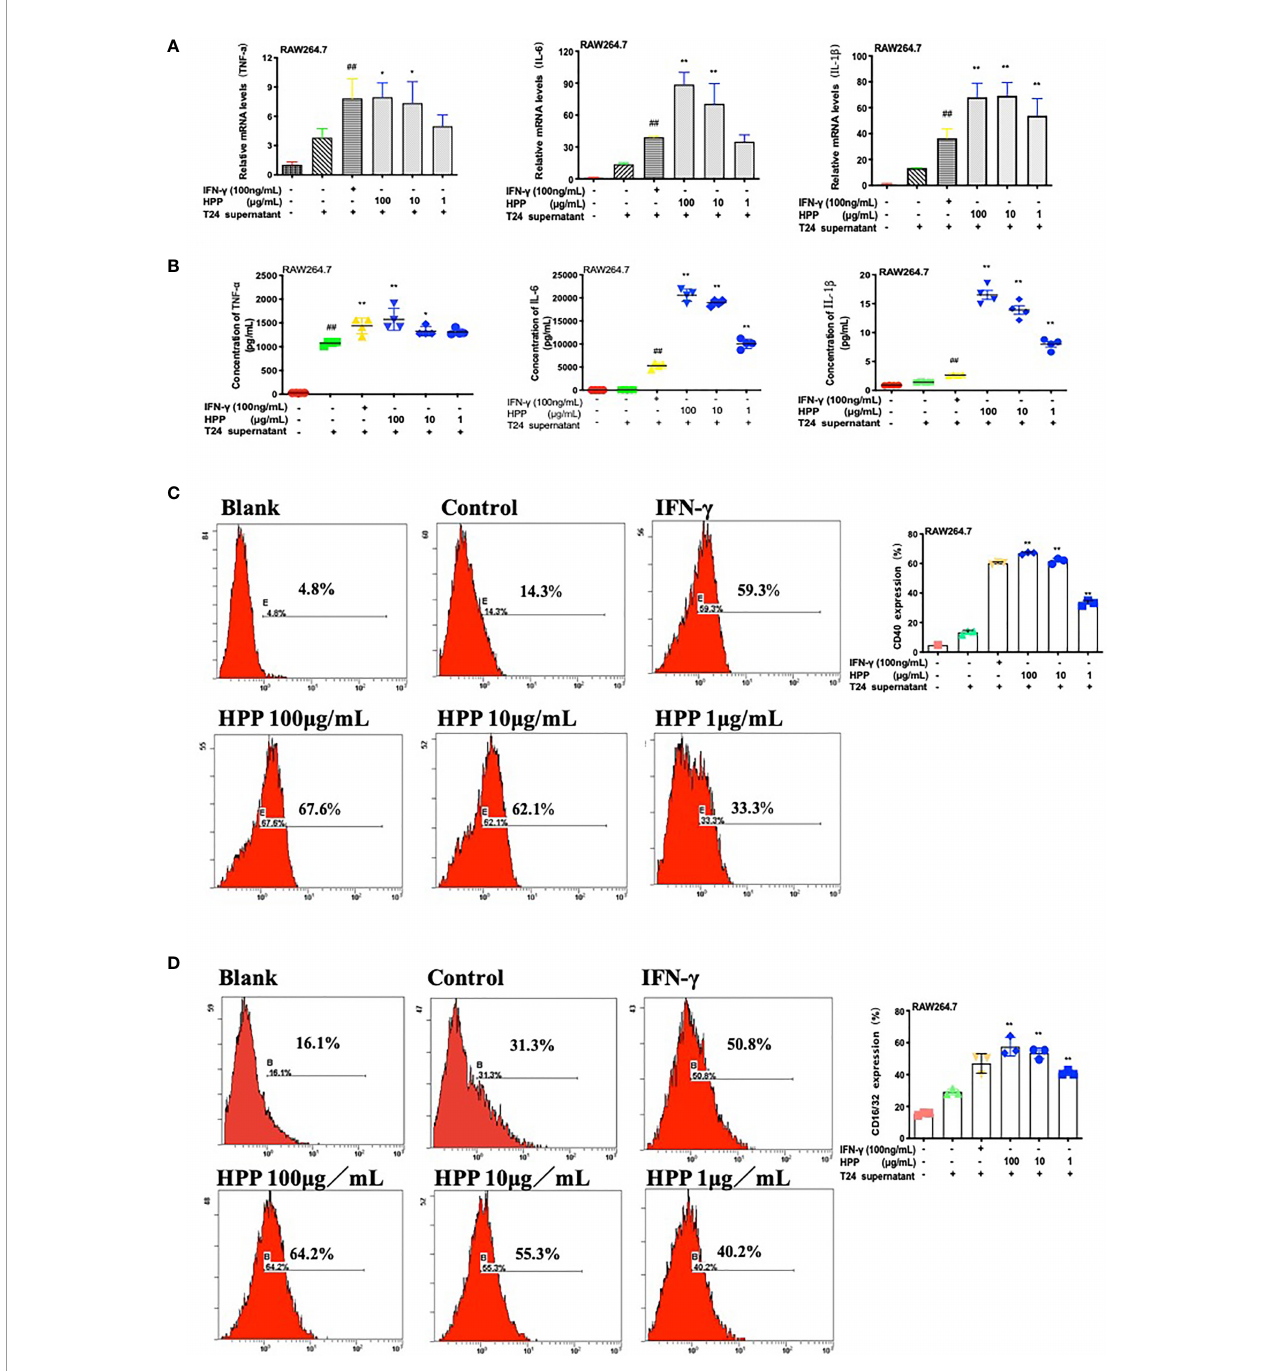
FIGURE 5 | HPP drives TAMs toward the M1 subtype. (A) The expression of IL-1 b , TNF- a , and IL-6 mRNA in RAW 264.7 cells treated with HPP for 24 h, followed by measuring the mRNA levels by qRT – PCR. (B) The secretion of IL-1 b , TNF- a , and IL-6 in macrophages treated with HPP. (C, D) Flow cytometry detection of CD40 and CD16/32, the signature markers of M1 cells. Values are given as the mean ± SD from three independent experiments. Compared with the control group, ## P < 0.01; compared with the RAW 264.7+T24 control group, * P < 0.05 and ** P <